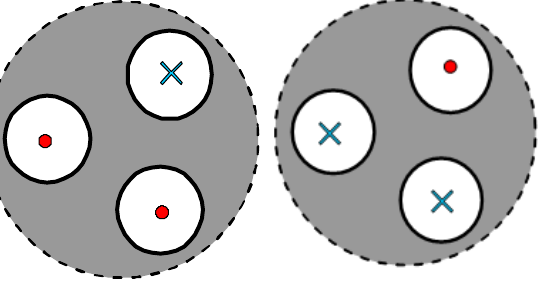
Figure 3. Innovative system [103]; with two options of circulating heat carrier (LG-11b in Table 3). Table 3. Constructions of borehole heat exchangers (Laboratory of Geoenergetics at the Faculty of Drilling, Oil and Gas at AGH UST in Krakow)